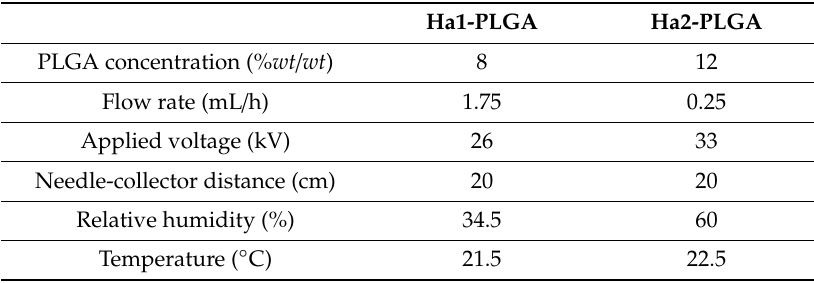
Table 1. Electrospinning